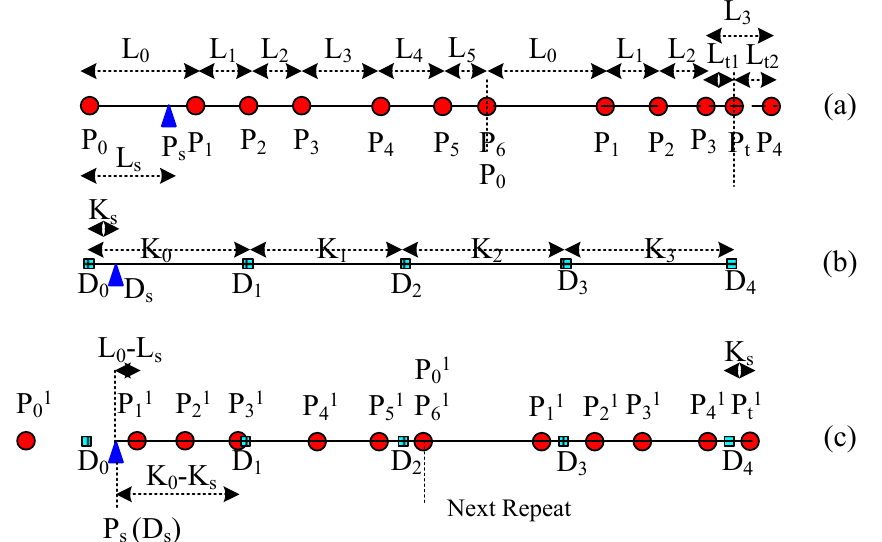
Figure 8. The mapping procedure for the different starting points. ( a ) Calculate the distance to the random mapping start P s for each key control point on the source yarn. ( b ) Calculate the distance to the random mapping start D s for each key point on the target curve. ( c ) Combine and rearrange all the key points of both source yarn and target curve in order on the new central curve according to the distances to the random mapping start P s or D s .